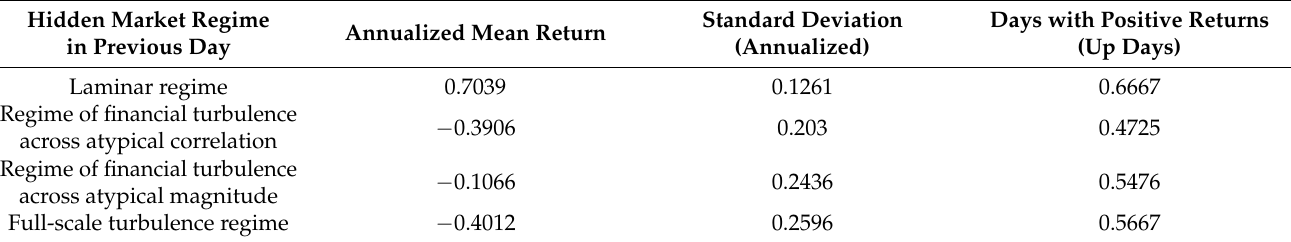
Table 11. Daily returns distribution for the S&P 500 during switches among four Markov regimes.